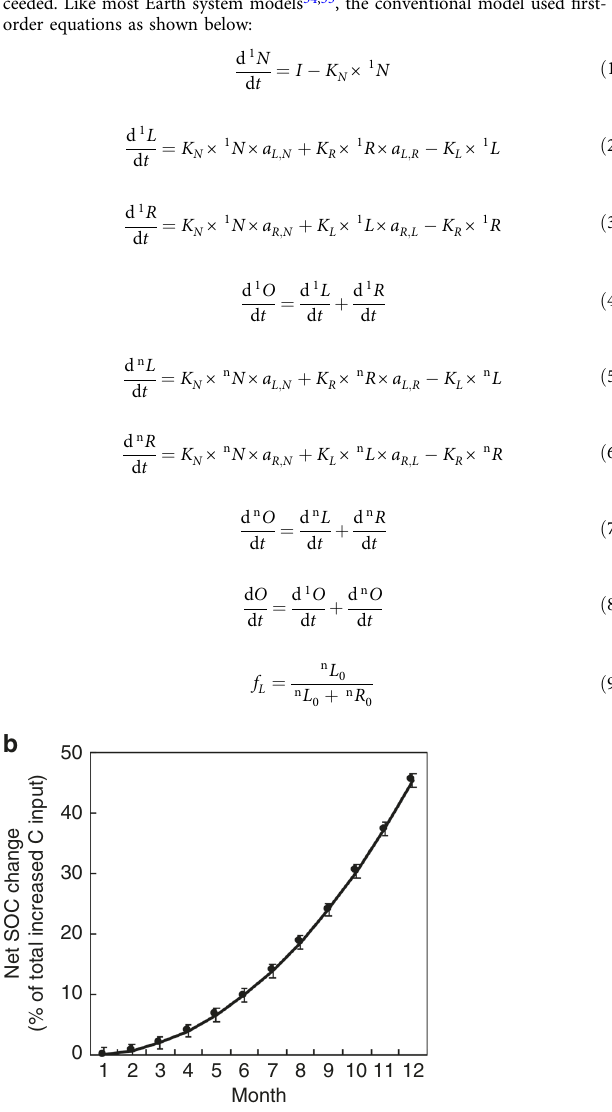
meters indicates that the interactive model is able to well repre-